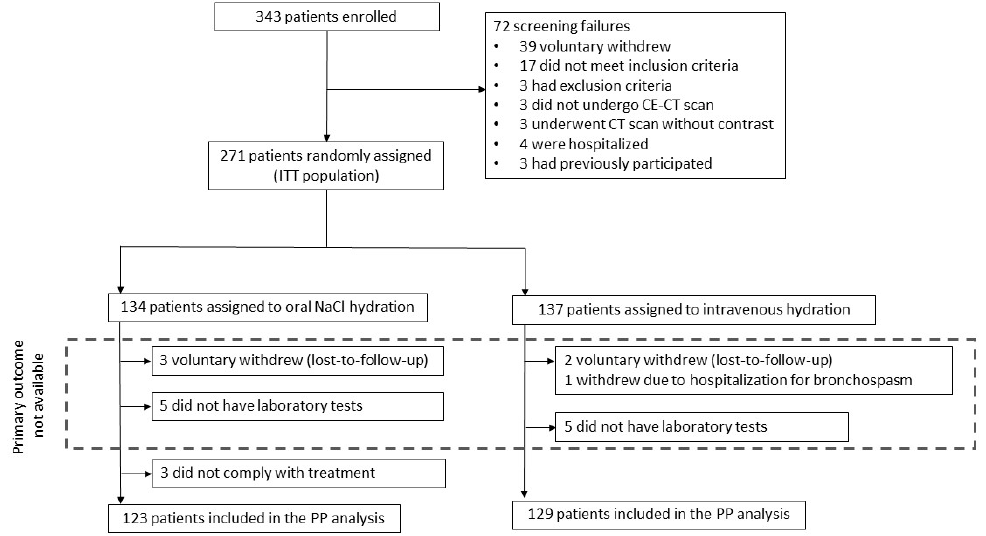
Figure 1. Trial profile. CE-CT: contrast-enhanced computerized tomography; ITT: intention-to-treat; Figure 1. Trial pro fi le. CE-CT: contrast-enhanced computerized tomography; ITT: intention-to-treat; PP: per-protocol. PP: